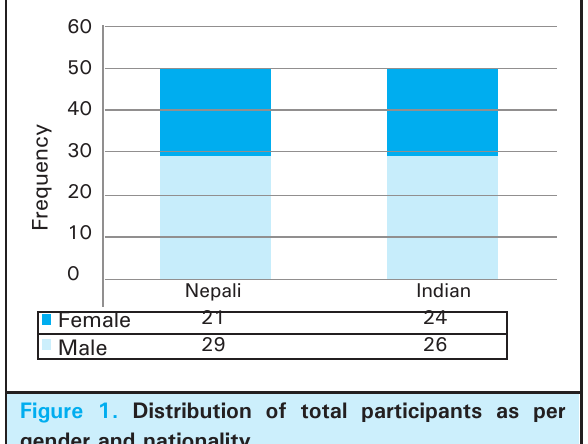
nationality and gender (Figure 2).